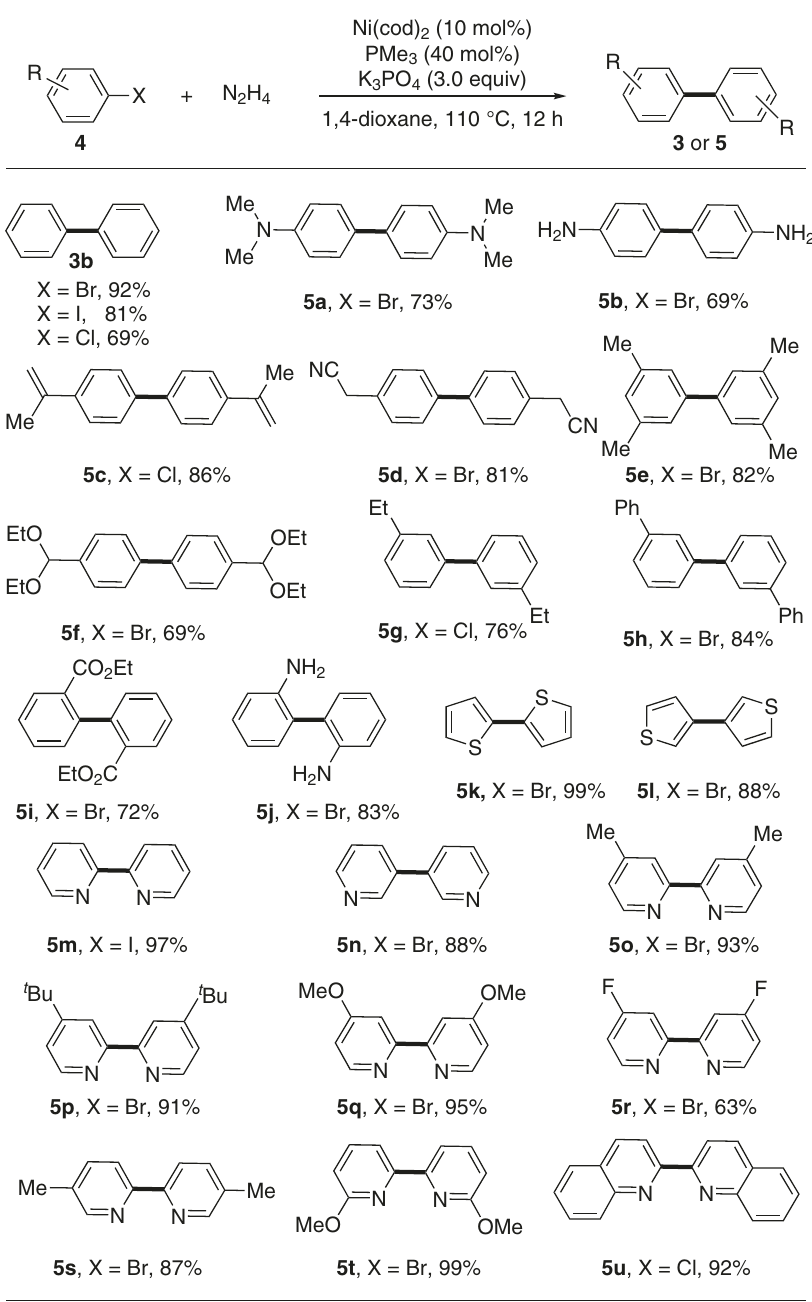
Fig. 4 Scope of aryl halides 4 . Reaction conditions: 4 (0.2 mmol), N 2 H 4 (0.1 mmol), Ni(cod) 2 (10 mol%), PMe 3 (40 mol%), K 3 PO 4 (0.6 mmol), 1,4-dioxane (1.0 mL), 110 °C, 12 h under N 2. . Reported yields are the isolated